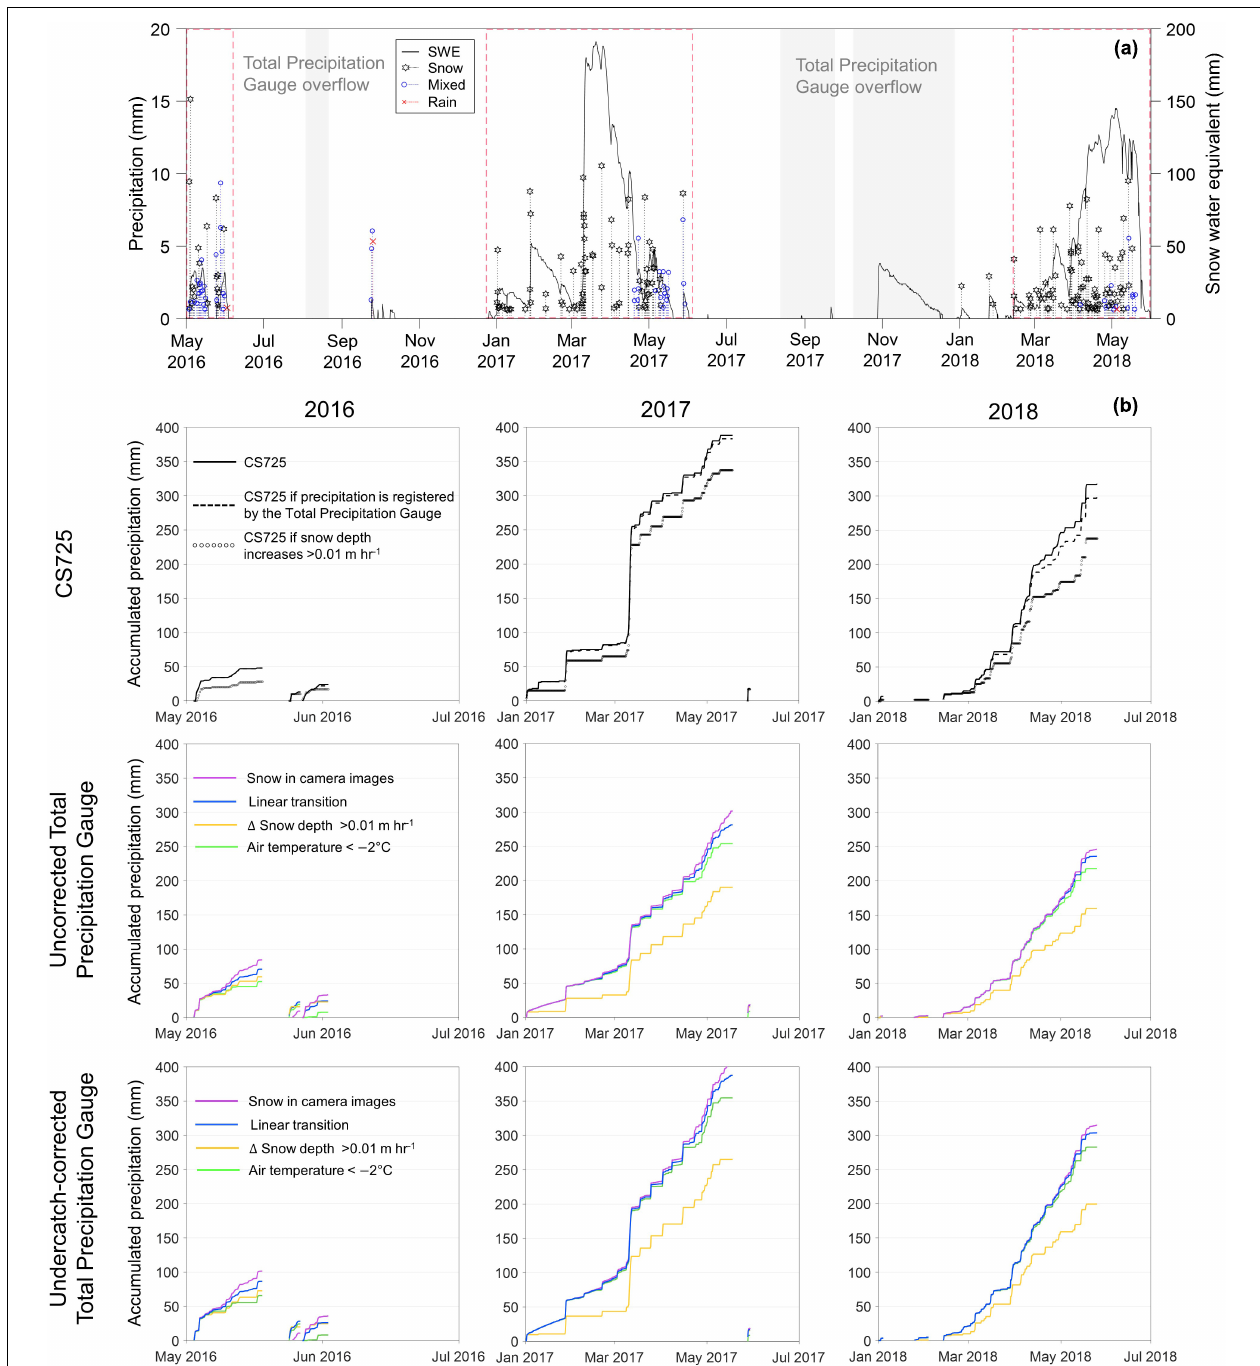
FIGURE 4 | Cumulative SWE patterns for the CS725 and the Total Precipitation Gauge when substantial snow cover is present. (a) SWE measured by the CS725 and measured precipitation, split into solid, mixed and liquid phases using temperature thresholds. The three periods studied in panel (b) are highlighted in red dashed boxes. (b) Cumulative precipitation sums for the CS725 and the raw and undercatch corrected Total Precipitation Gauge using snow cover, air temperature, snow depth and a linear phase transition to determine when solid precipitation